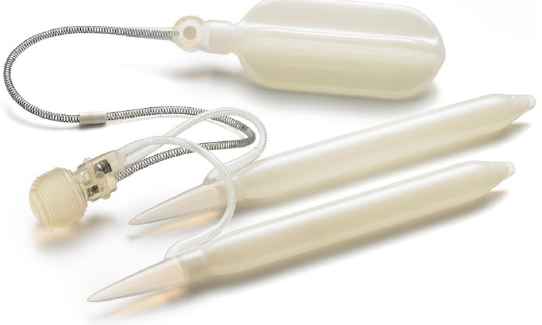
Figure 1. The Coloplast inflatable penile prosthesis Titan with One Touch Release pump and cloverleaf reservoir. Courtesy of Coloplast, www.us.coloplast.com (accessed on 16 November 2022). Both InhibiZone ® and HydroVantage ® are still mainstays of the two manufacturers. The effort to build an increasingly efficient and reliable device led to the pump and reservoir innovation. In 2004 AMS introduced the Tactile Pump, which is easier to grab and can transfer more fluid per squeeze. Shortly after, the Momentary Squeeze was pre- sented. Thanks to this innovation, the patients could press the button just once to deflate the cylinders without holding them. In 2010 AMS released the Conceal reservoir: its flattened shape optimized the sub- muscular placement compared to the spherical one. On the other hand, Coloplast 2000 provided a lock-out valve for the reservoir to de- crease the risk of auto-inflation (Figure 2). The lock-out mechanism contains a “poppet” valve that does not allow fluid to exit when pressure is applied to the reservoir. Figure 2. Coloplast cloverleaf reservoir with the lock-out valve is available in 75 and 125 ml sizes. Courtesy of Coloplast, www.us.coloplast.com (accessed on 16 November 2022).